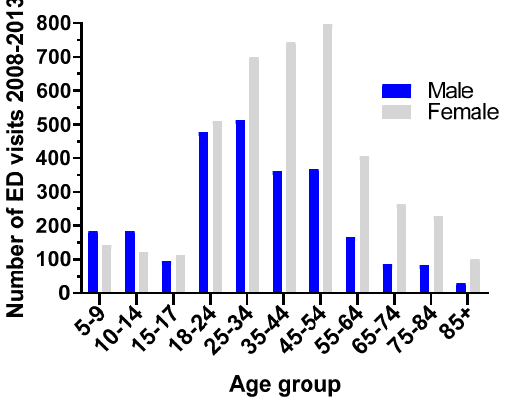
Figure 2. Cases of asthma-related ED visits between 2008 and 2013 separated by sex and age.